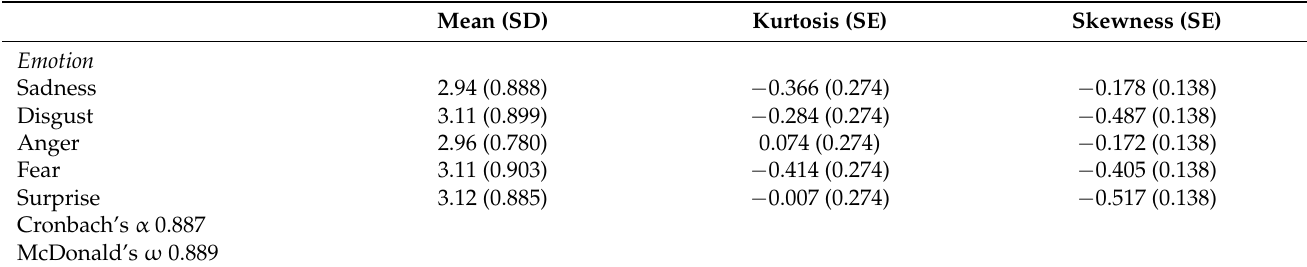
Table 2. Mean scores, standard deviation, values of kurtosis, skewness and their relative standard errors for the mean score of each emotion and for each item of the health